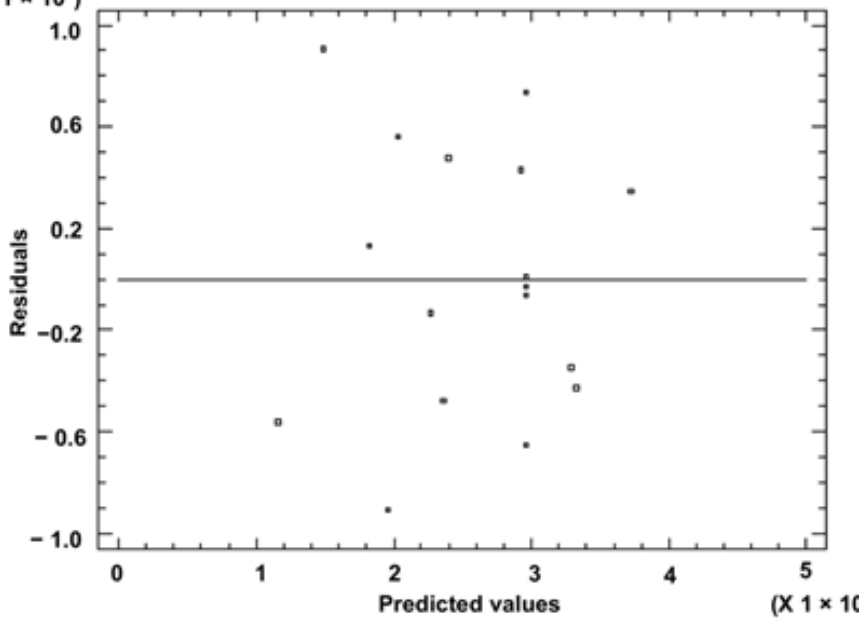
Figure 4. Residual versus predicted values of a BBD design. The regression equation of response (total area), depending on the sample weight (A), extraction temperature (B) and extraction time (C), and the response (total area), determined on the basis of the second-order polynomial equation—Equation (1)—was: